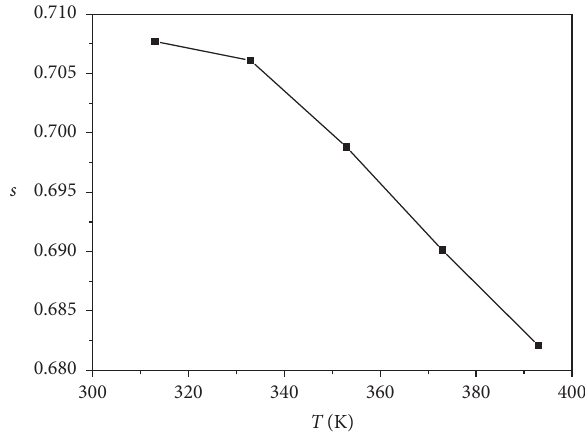
Figure 5: Exponent s as a function of temperature.